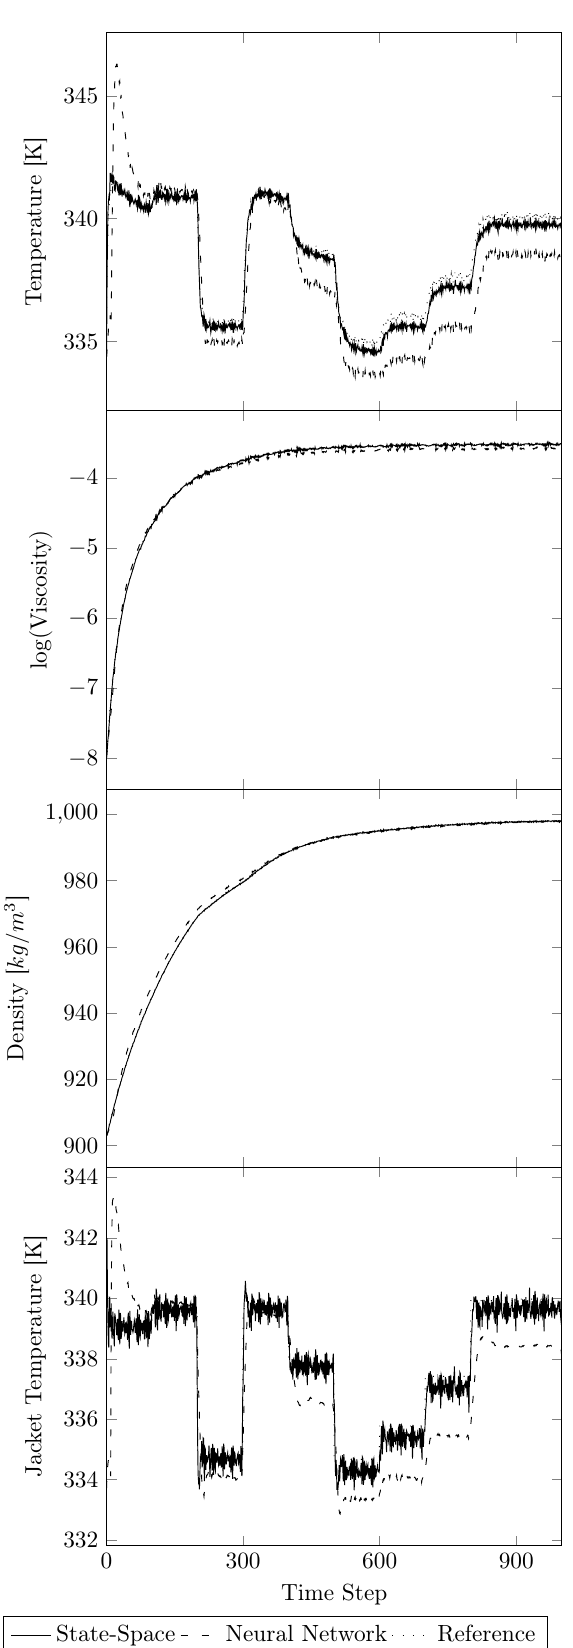
Figure 11. Implementation of state-space models and NARX networks into MPC subject to measure- ment noise and using newly generated reference